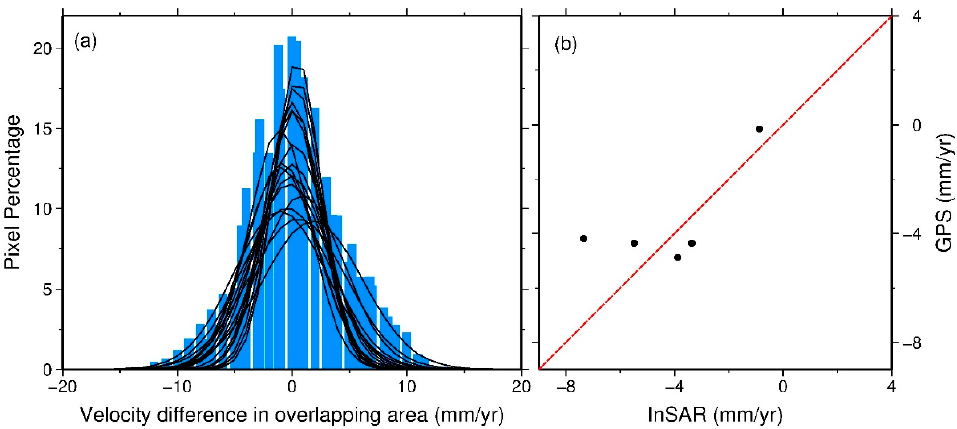
Figure 4. Accuracy of InSAR-derived results. ( a ) The average deformation rate difference in the overlapping areas of adjacent tracks. Blue bars represent the histograms of the average rate difference, and black lines represent the normal distribution fitting of these rate differences; ( b ) The average deformation rate difference between the InSAR results and the GPS station results.